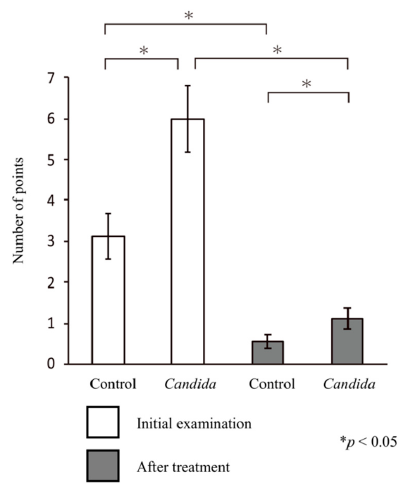
Figure 3. Changes in intraoral symptoms. The analysis of the scores for intraoral symptoms showed significant differences in the changes in intraoral symptoms between the control and Candida groups, both at the initial visit and after prosthetic treatment ( p < 0.05). The results showed significantly improved intraoral symptoms after treatment in both groups ( p <